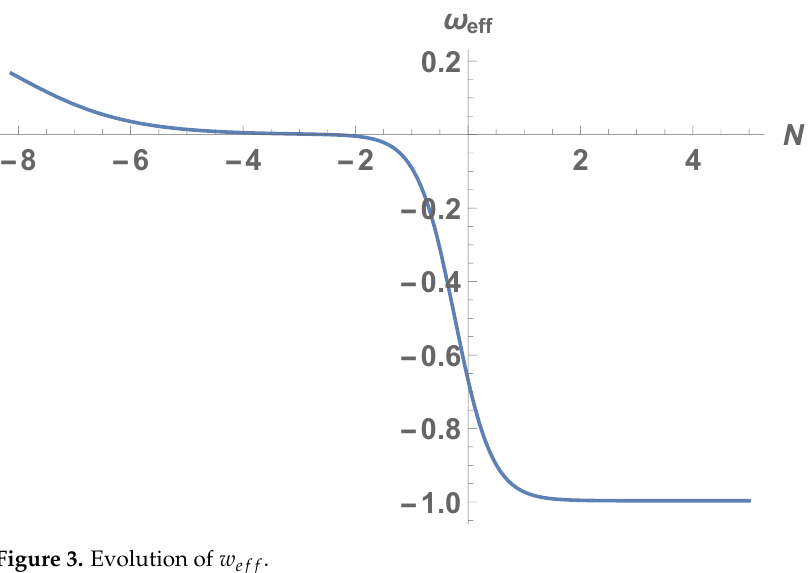
Figure 3. Evolution of w ef f